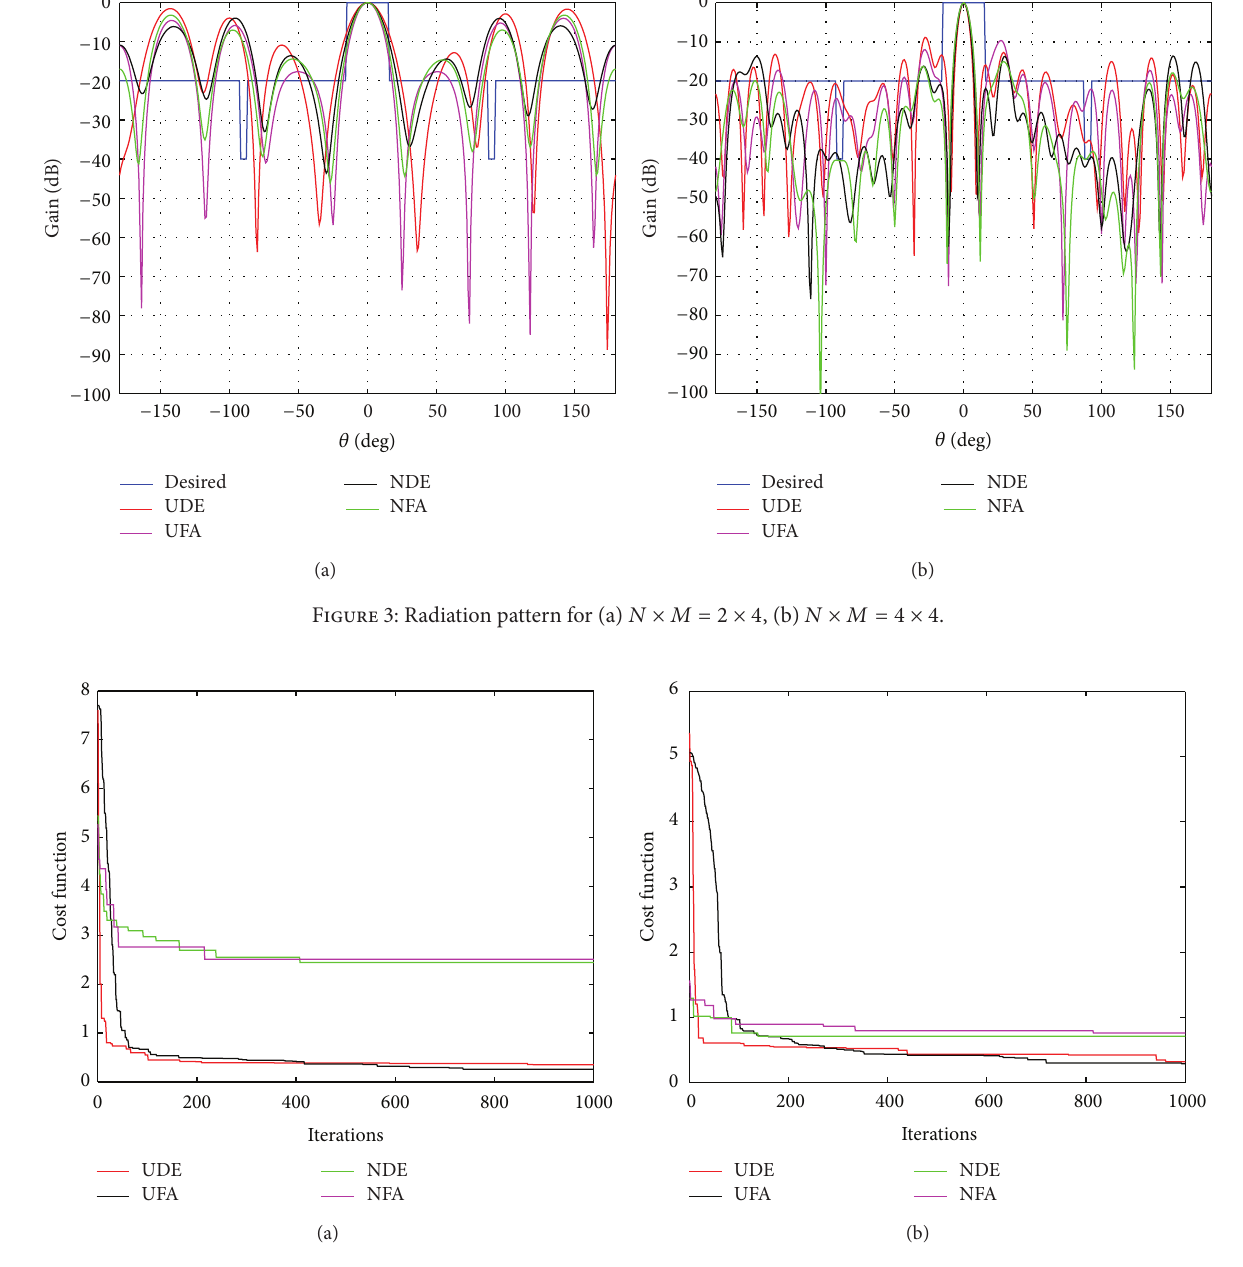
Figure 4: Fitness curves for (a) 𝑁 × 𝑀 = 2 × 4 , (b) 𝑁 × 𝑀 = 4 × 4